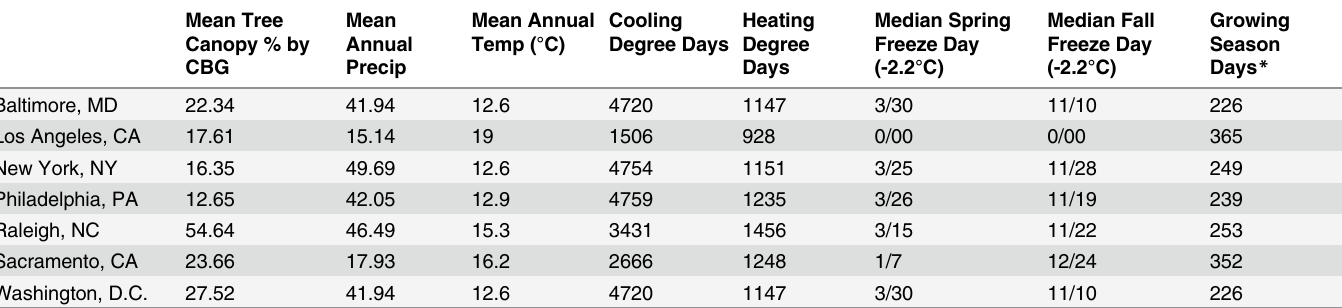
Table 2. Site Descriptions — Biogeophysical variables for the seven study cities. Mean Tree Canopy %